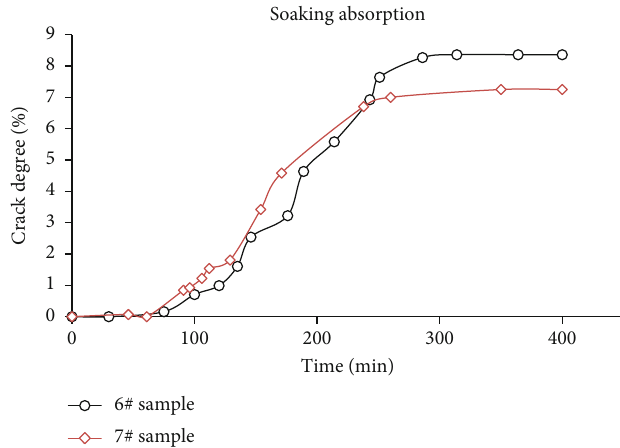
Figure 11: Time history curves of crack degree of 6# ~ 7#